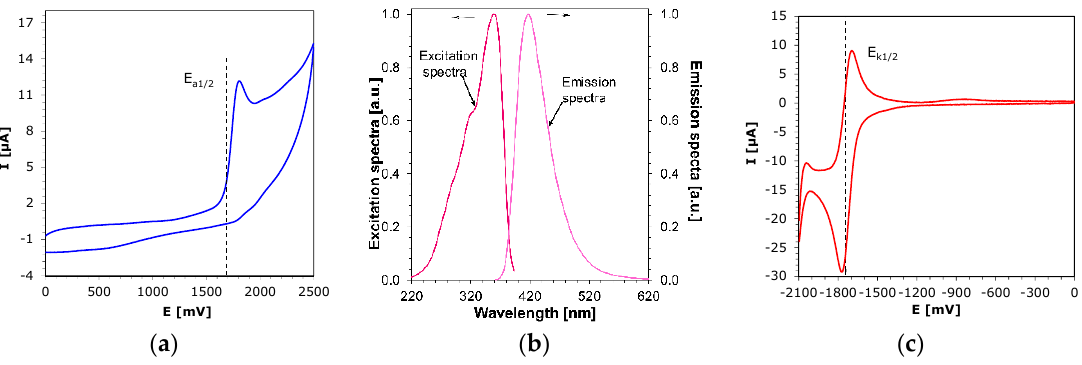
Figure 8. ( a ) Cyclic voltammetry for oxidation process (CV ox , vs. Ag / AgCl) experiments in ACN (containing 0.1 M tetrabutylammonium hexafluorophosphate) for the B2. ( b ) Absorption and fluorescence spectra for the determination of the excited singlet state energy for B2 derivatives. ( c ) Cyclic voltammetry for reduction process (CV red , potential vs. Ag / AgCl) experiments in ACN (containing 0.1 M tetrabutylammonium hexafluorophosphate) for the